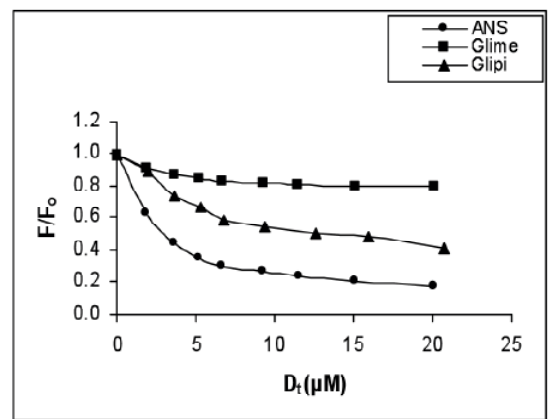
Figure 4. Quenching of HSA fluorescence by drugs and ANS under identical conditions